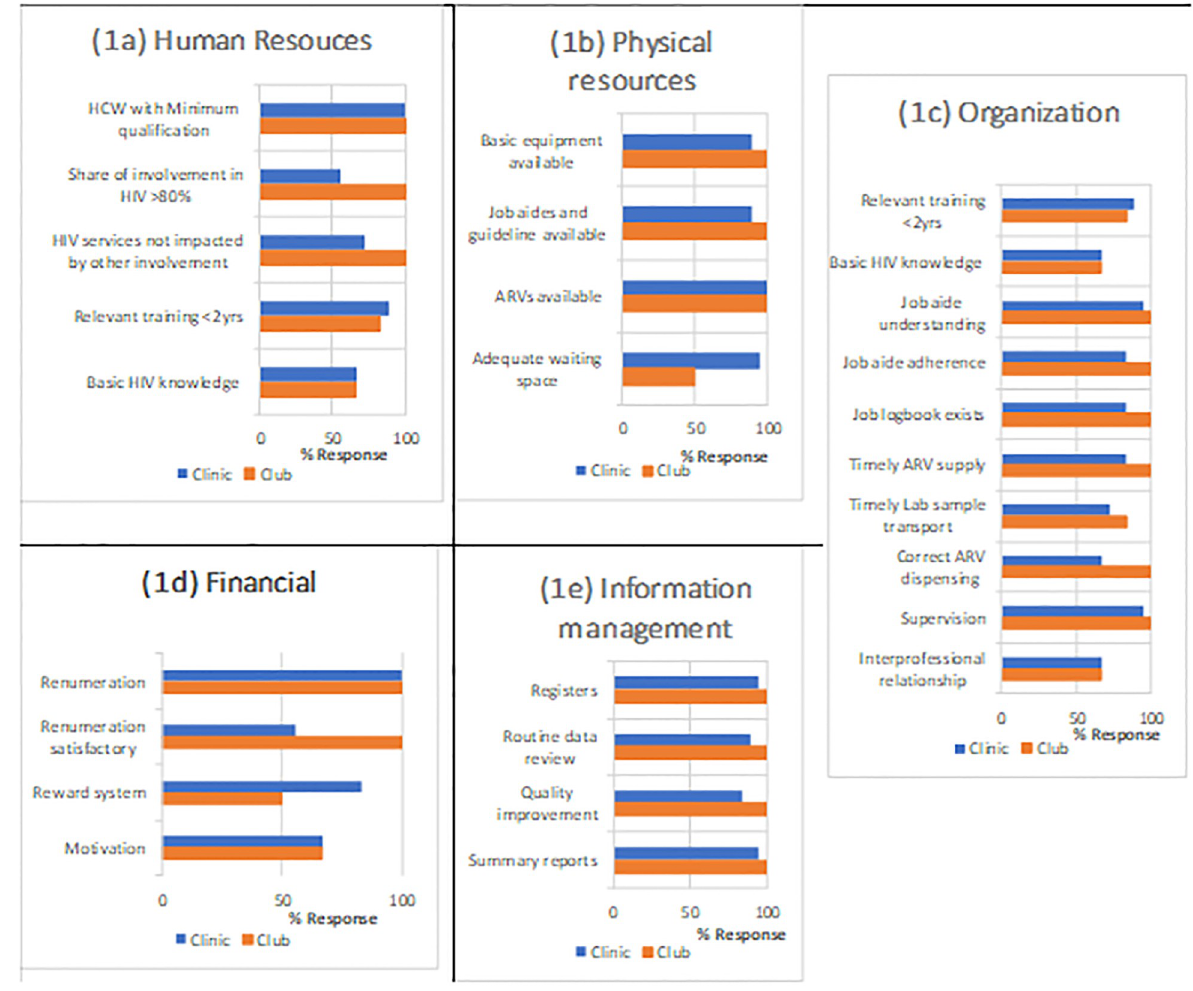
Fig 1. a-e : Structure of care: Health Care workers